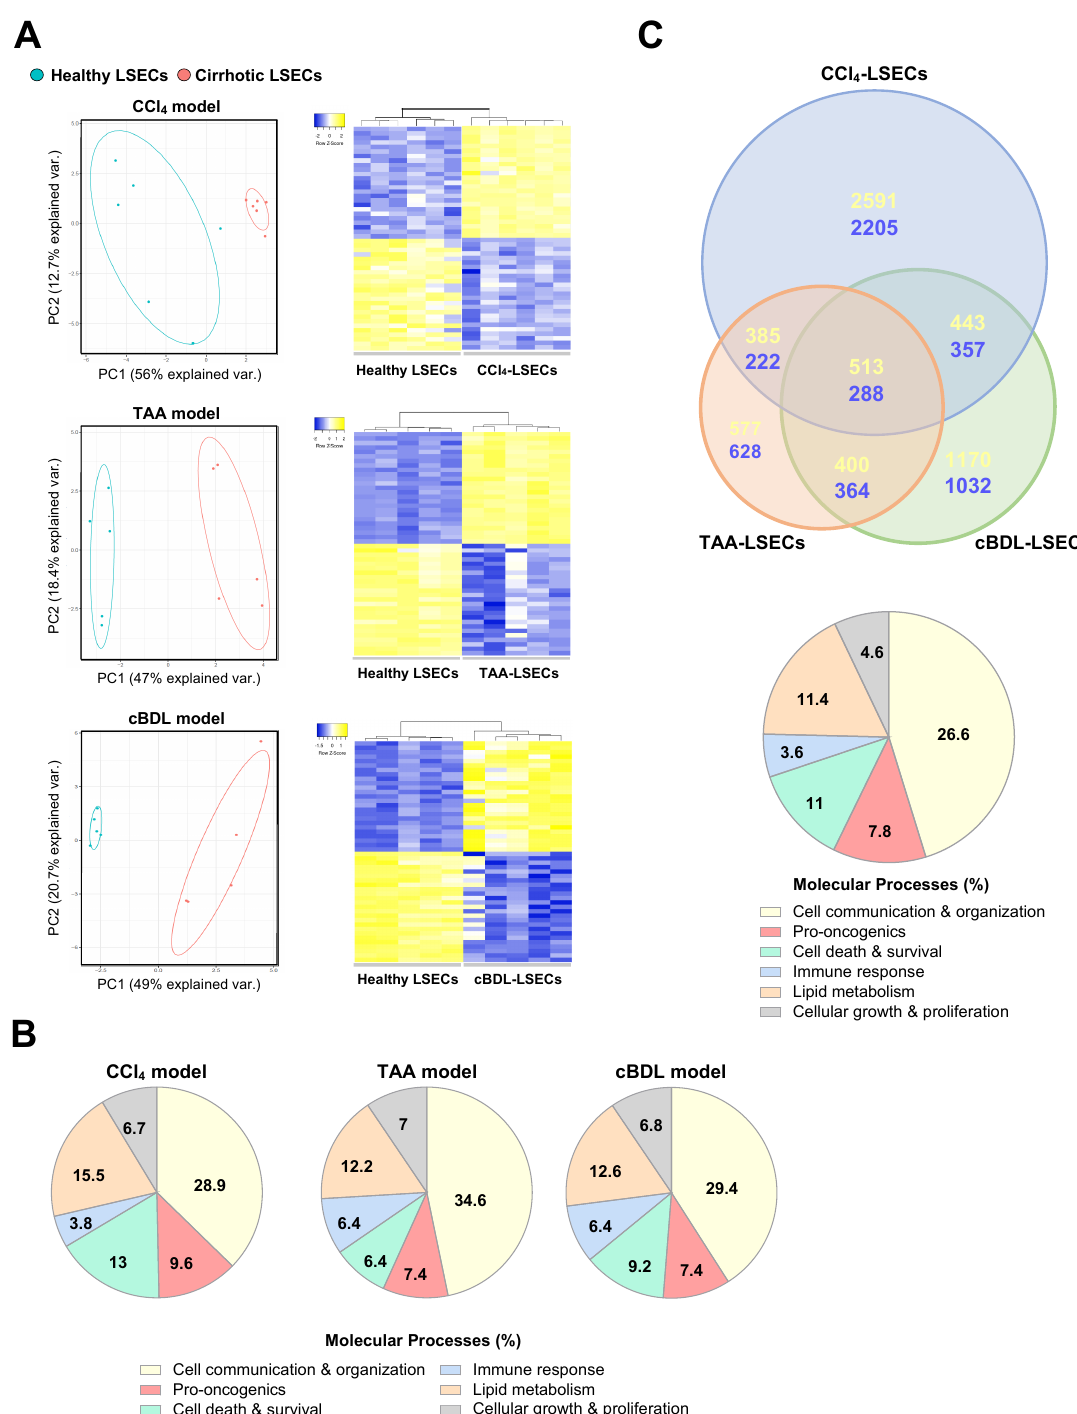
Figure 1. LSECs transcriptome in experimental models of advanced CLD. ( A ) Transcriptomic profile of LSECs isolated from CCl 4 , TAA and cBDL pre-clinical models of chronic liver disease and healthy animals represented as Principal Component Analysis graphic (Left), and top 25 up- (yellow) and down-regulated (blue) genes represented in heatmaps (Right). ( B ) Molecular processes deregulated in cirrhotic LSECs analysed by Ingenuity Pathway Analysis software. ( C ) Venn diagram showing the commonly up-regulated (yellow) or down-regulated (blue) genes comparing three pre-clinical models of CLD (Up), and main molecular processes that define the common differentially expressed genes (Bottom). n = 5–6 independent LSECs isolations per experimental model & healthy. Significant differences are considered in RNAseq when fold-change > 1.5 and p -value <